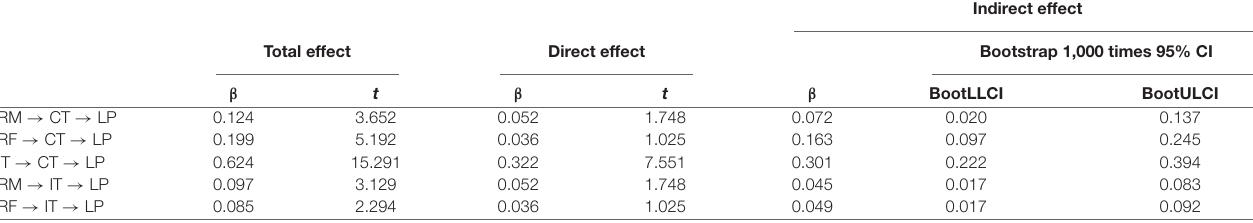
TABLE 5 | Results of mediating